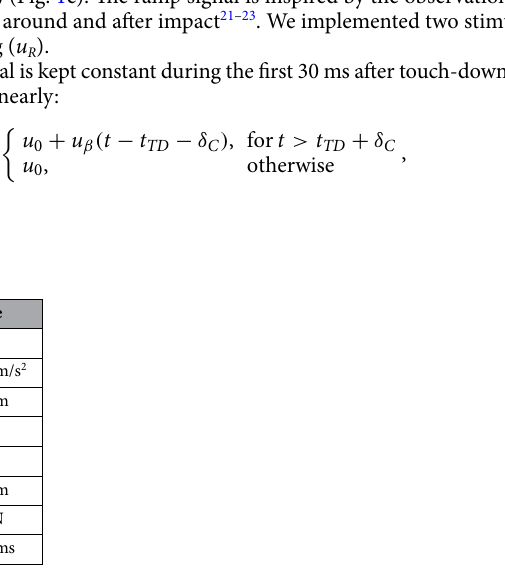
Table 1. Model parameters, adapted from Ref 16